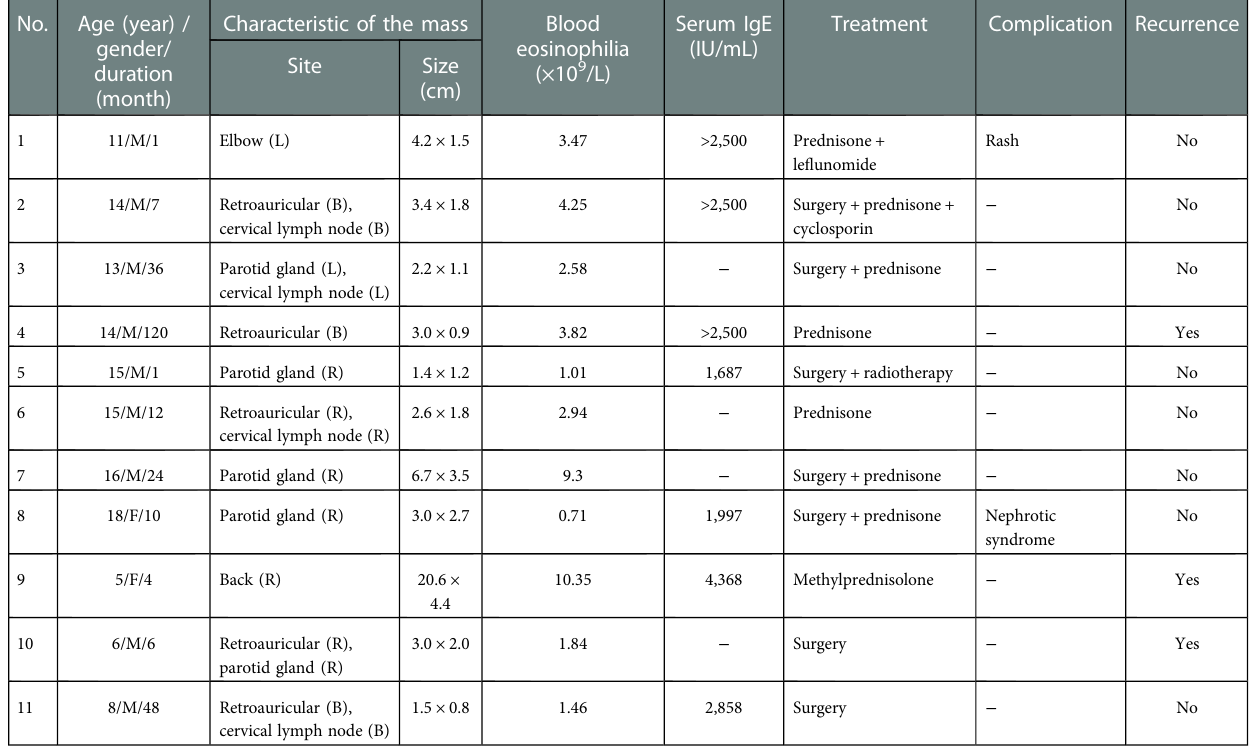
TABLE 1 Clinical feature, treatment and result of 11 pediatric patients with KD.